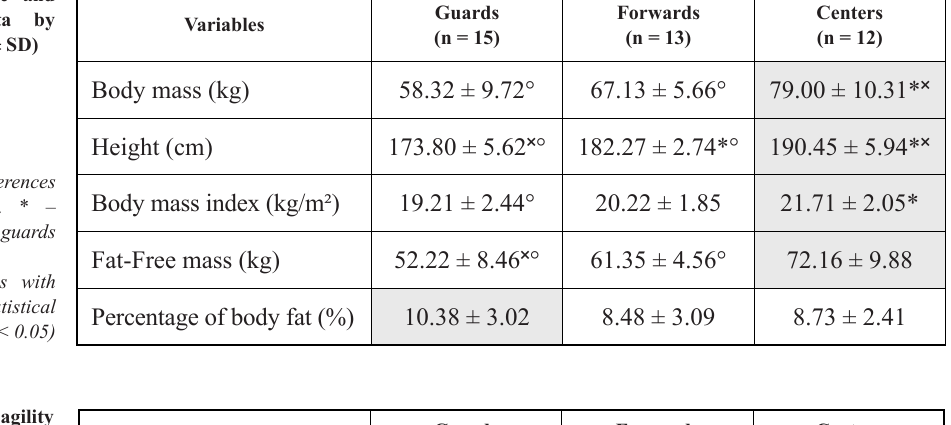
and power tests relative to playing positions (mean ±